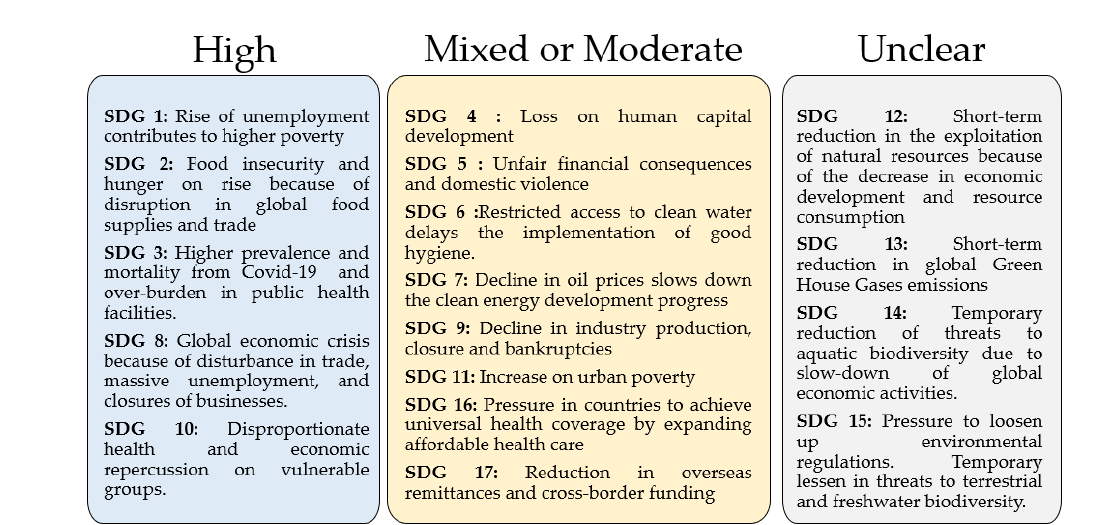
Figure 1. Short-term impacts of COVID-19 on the Sustainable Development Goals (SDGs) (Modified from Sachs [13]).